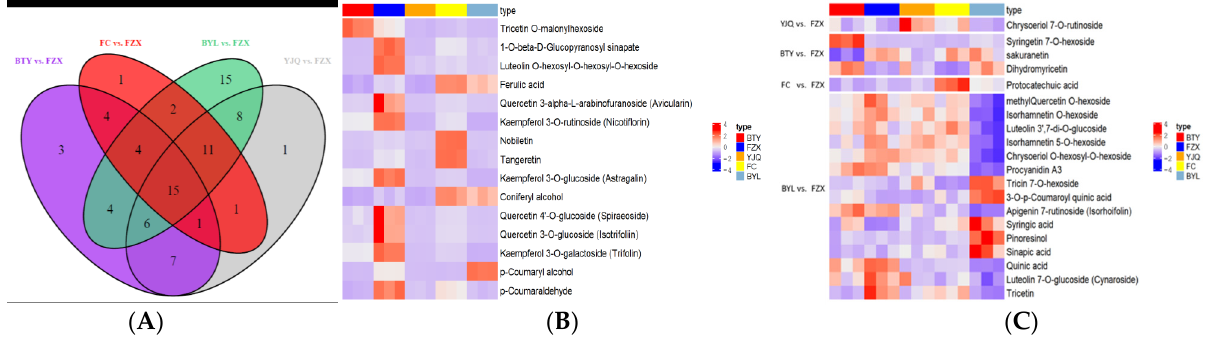
Figure 6. ( A ) Wayne diagram, ( B ) heat map of common differential metabolites, and ( C ) specific differential metabolites. The color sequence from red to dark blue indicates metabolites abundance from high to low in heat map.